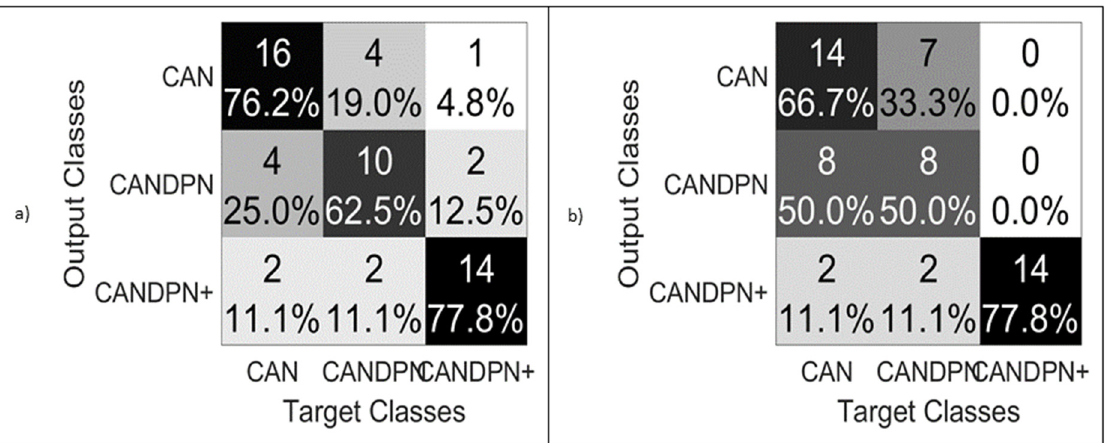
Figure 6. Performance comparison (confusion matrix) between the multiclass SVM classifier and the multiclass RF classifier. ( a ) Confusion matrix of SVM classifier; ( b ) confusion matrix of RF classifier; classes: 1. CAN, patients with CAN; 2. CANDPN, with DPN and CAN; 3. CANDPN+, patients with NEP and/or RET with CAN and DPN .